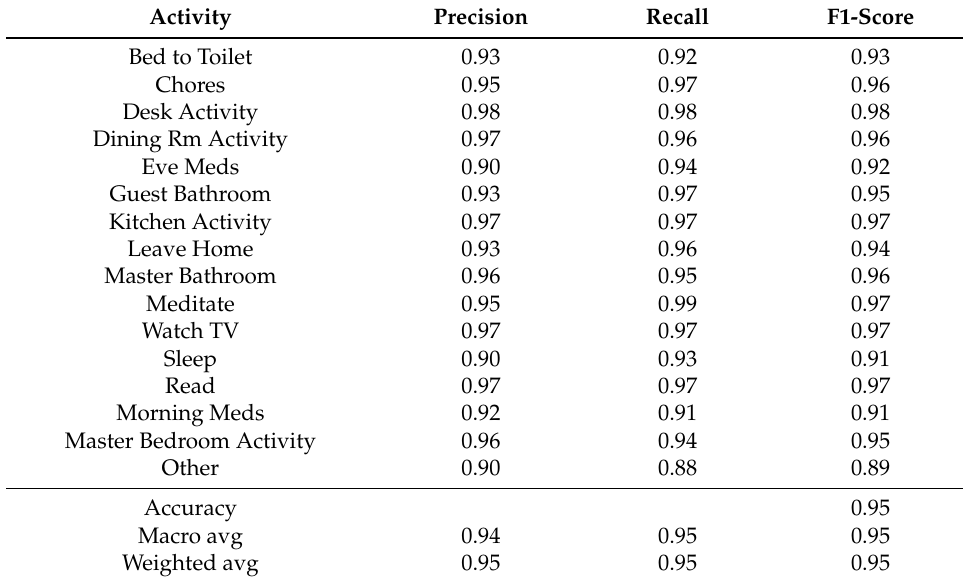
Table 3. Summary table of results by activity.